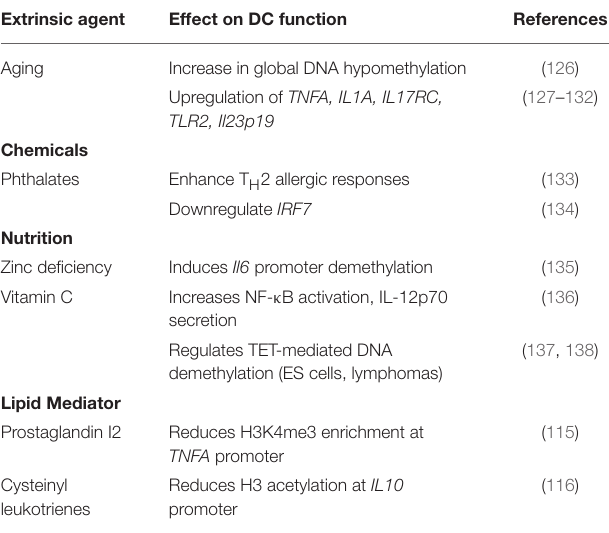
TABLE 3 | Environmental factors that shape the epigenome in